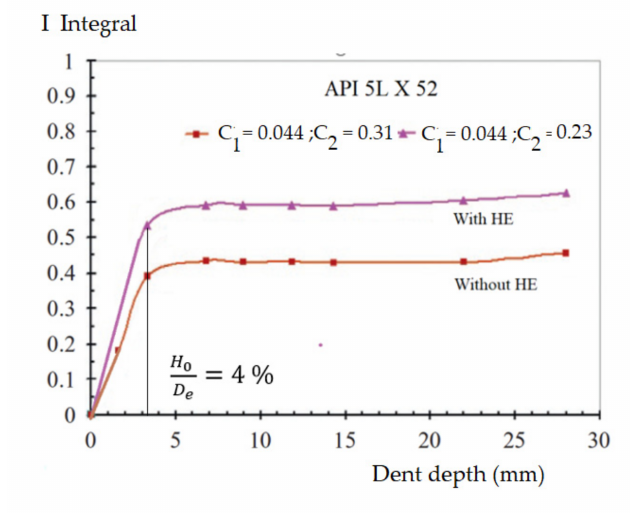
Figure 21. Integral I obtained by Finite element computation (Oyane’s criterion) versus dent